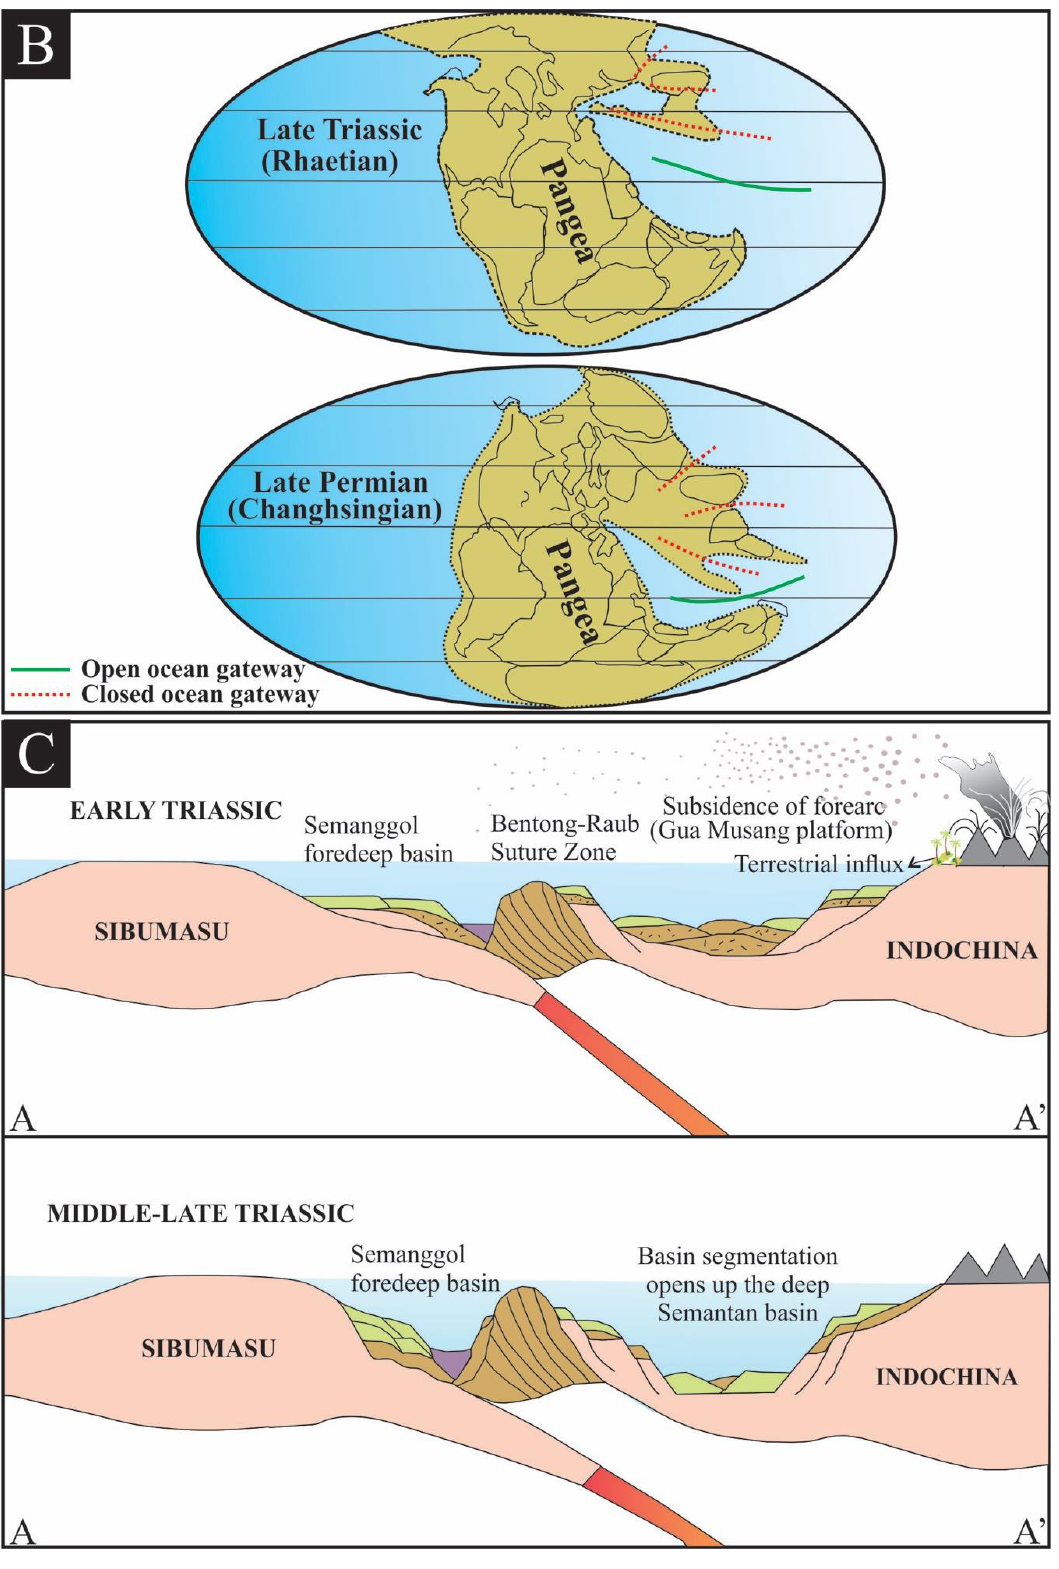
Figure 1. ( A ) Simplified geological map of Peninsular Malaysia showing the distribution of black shale outcrops [21]; ( B ) Paleogeographic location of Indochina and Sibumasu blocks during the Late Permian to Late Triassic period [16]; ( C ) The cross-section (A-A’) presents the subsurface structural framework .